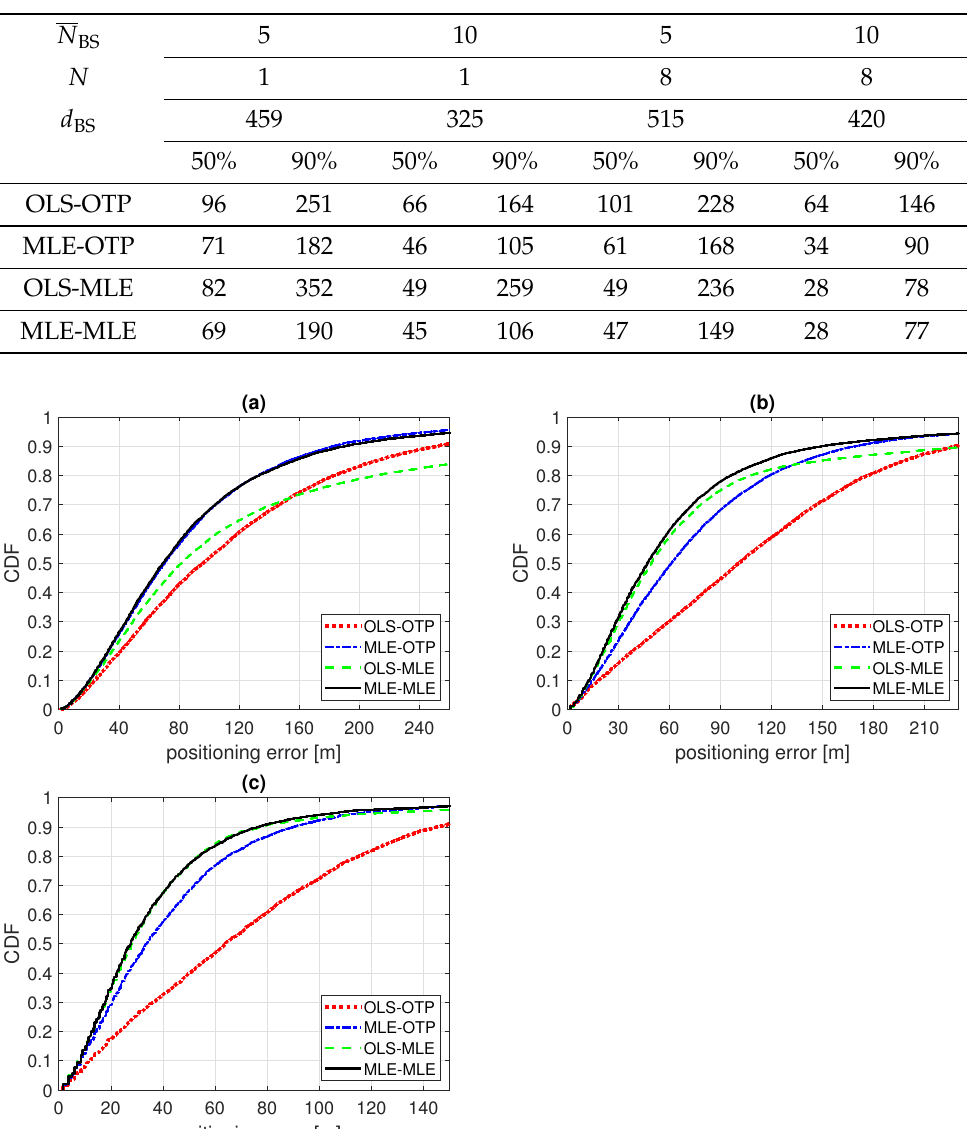
Table 4. Positioning error, in meters, 50th and 90th percentiles of Example 2. Base stations have omnidirectional ( N = 1) or directional antennas ( N = 8) and the average number of contacted BSs is N BS = 5 or 10.